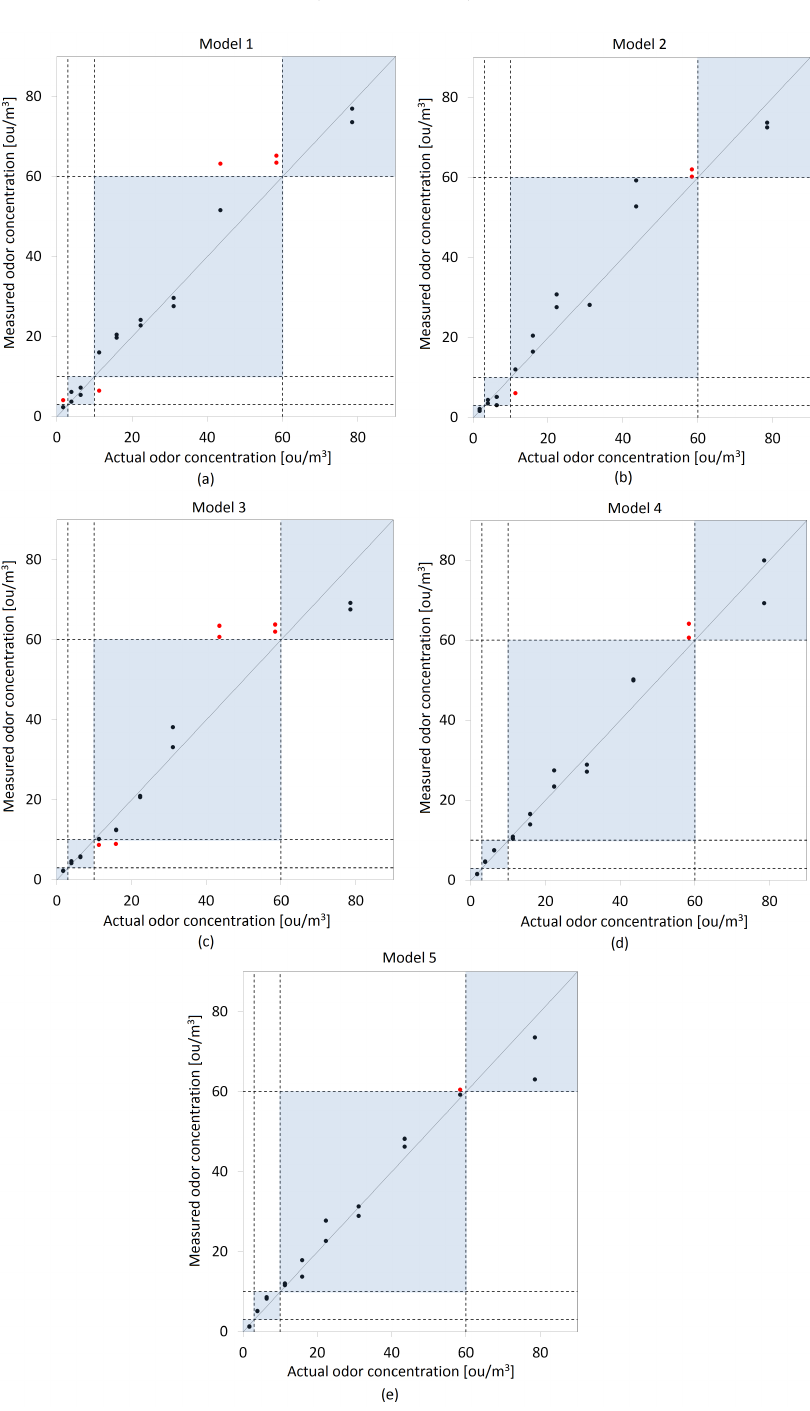
Figure 8. Validation plots of proposed models—actual and determined odor concentrations based on signal value in dB - S dB as an independent variable: ( a ) Model 1, ( b ) Model 2, ( c ) Model 3, ( d ) Model 4, ( e ) Model